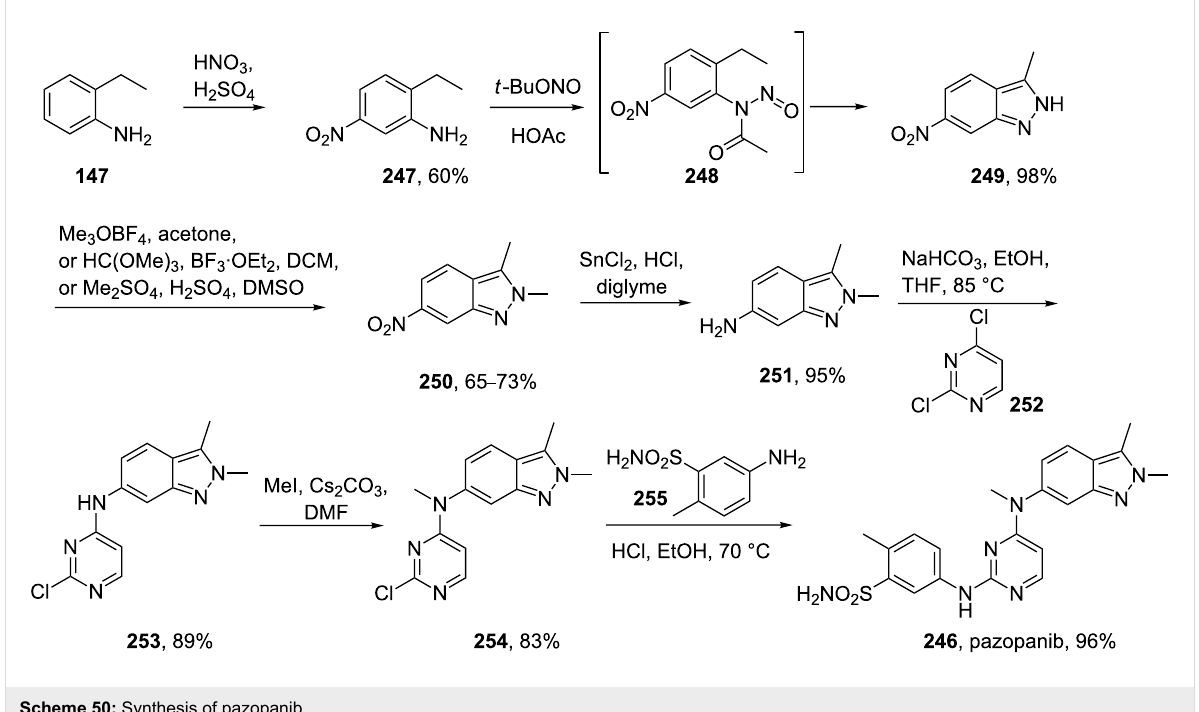
Scheme 50: Synthesis of